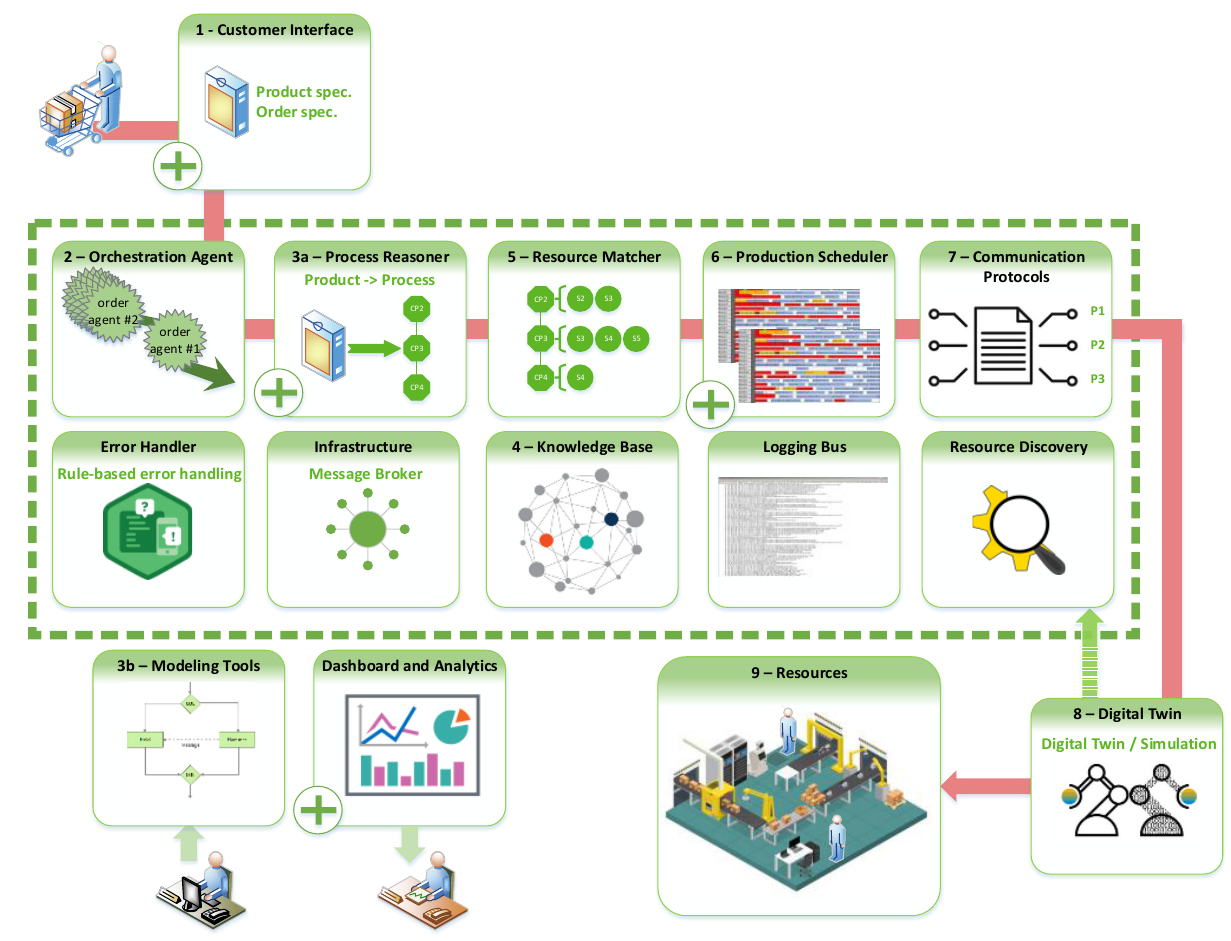
Figure 2. Architecture of the Orchestrator with the denoted ‘Happy flow’. On one side, the Orchestrator can be seen as a self-contained black-box. For end- customers, the output of the black-box is the desired product, the specification of which is given as an input to the system, while the entire production system is self-orchestrated in the background. On the other side, several elements of the Orchestrator are pluggable, to provide process and quality engineers with the possibility of adapting the solution to various use-case or even factory-specific requirements, e.g., the user interface. The plus symbols in Figure 2 denote these pluggable elements. The full red line depicts the orchestration ‘Happy flow’ (i.e., ‘Happy path’), which is a default orchestration scenario that follows the numbered elements. The outset is the user interface (number 1) and the closure is the execution of production using available Resources (number 9) without experiencing any error states or unexpected behaviour. Other elements, although not numbered, contribute to the integrity and completeness of the solution. Description of other orchestration scenarios goes beyond the scope of this paper. The overall architecture of the presented system is modular and is implemented as a set of software components packaged within Docker containers. Every software component is a software agent. Each respective entity has some intelligence attached to the software components, enabling the realisation of a modular, smart, and pluggable software infrastructure. The high scalability of the system and running on cross-platform with minimum time to set up is allowed by introducing de-coupled containers. They are started, stopped, and run in multiple instances independently and can be seen as isolated and complete micro-services. These containers are run and instantiated on-demand, depending on a multitude of factors such as the load on the existing container instances or the number of concurrent